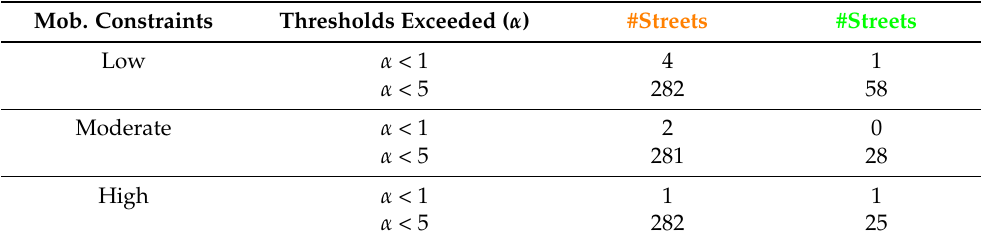
Table 8. Restoration streets